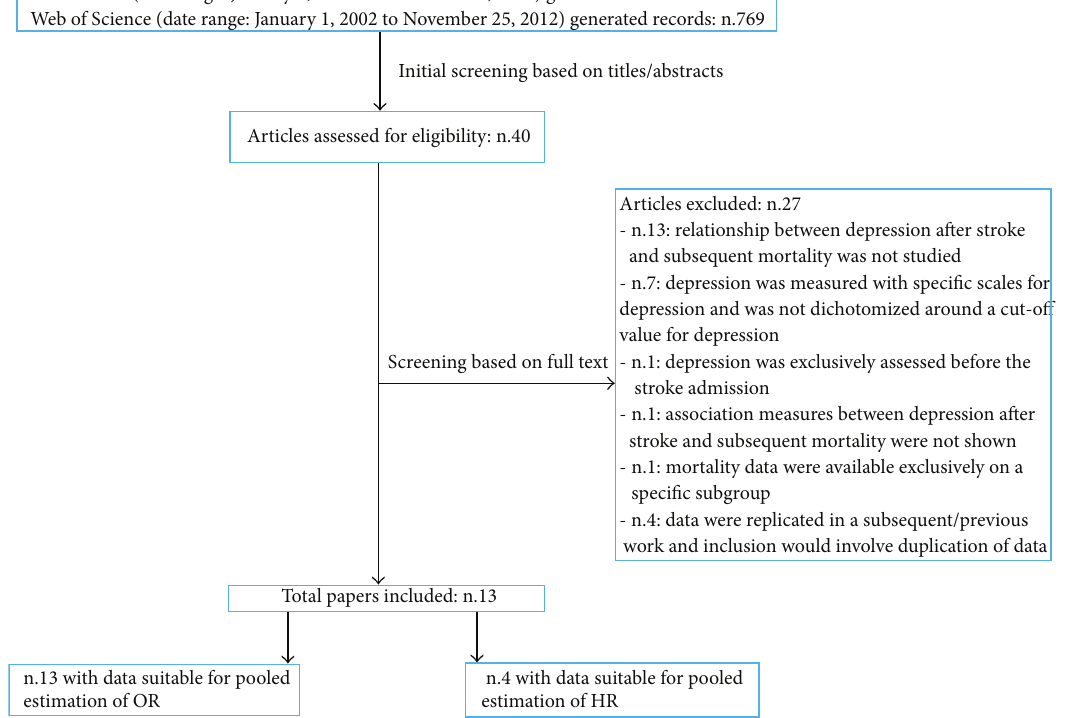
Figure 1: Flowchart: search results and excluded/included